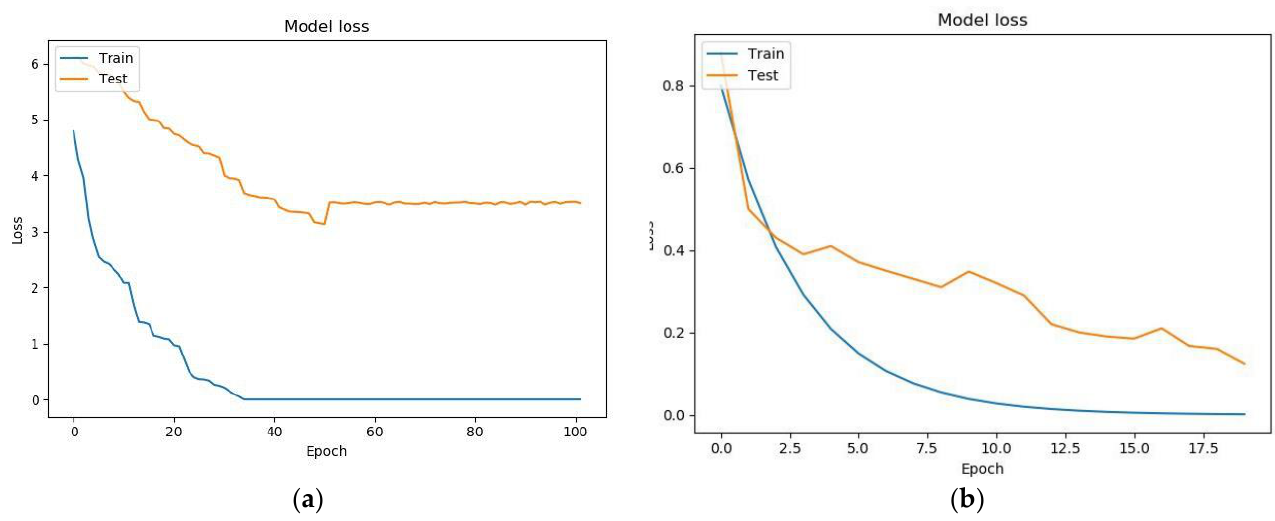
Figure 4. Graphs of the loss function for training neural networks using the angles of rotation and tilt of a mobile device as test data. ( a ) is a graph for a neural network constructed using a genetic algorithm. ( b ) is a graph of a neural network that was designed using an analytical method.